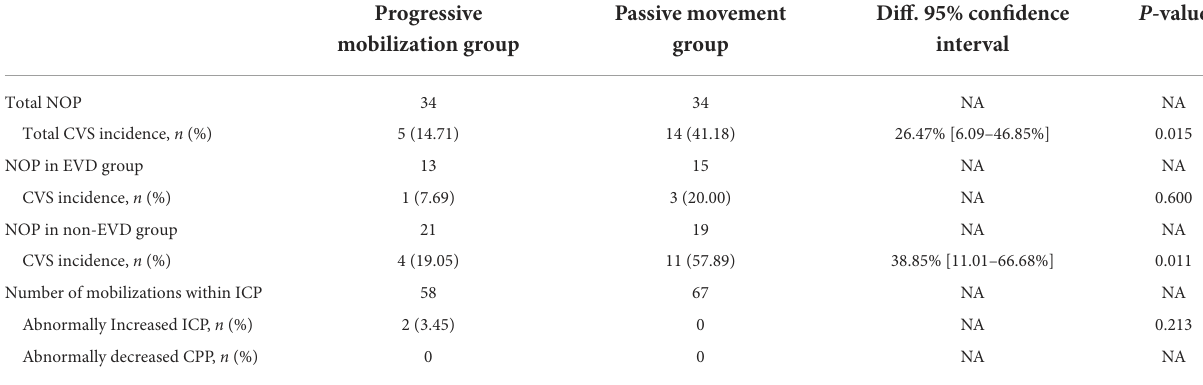
TABLE 4 Comparison of neuro-safety events between the two